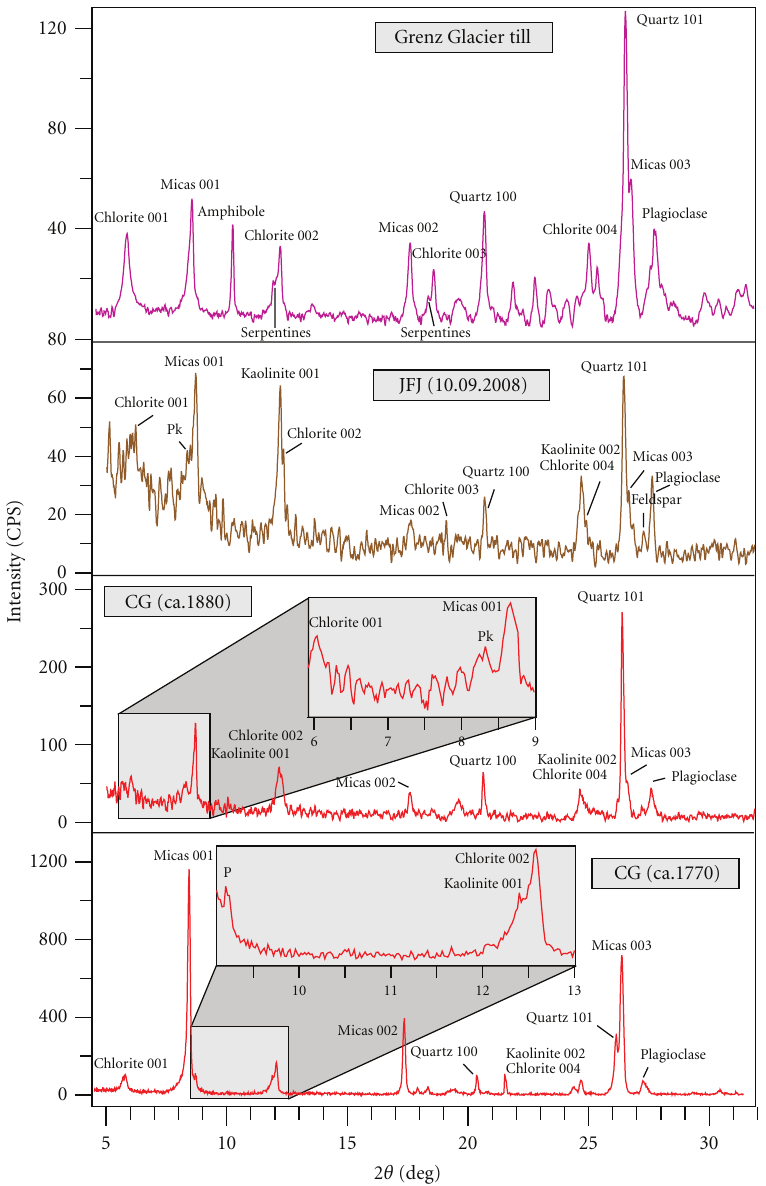
Figure 4: X-ray di ff raction (XRD) spectra of a fine-grained sediment sample (till or glaciogenic clay and silt) collected on the Grenz Glacier, from a Jungfraujoch sample (JFJ) and from two Colle Gnifetti ice-core (CG) samples enriched in Saharan dust. The minerals and the Miller indices associated with the major peaks are indicated. P: paragonite, and Pk: